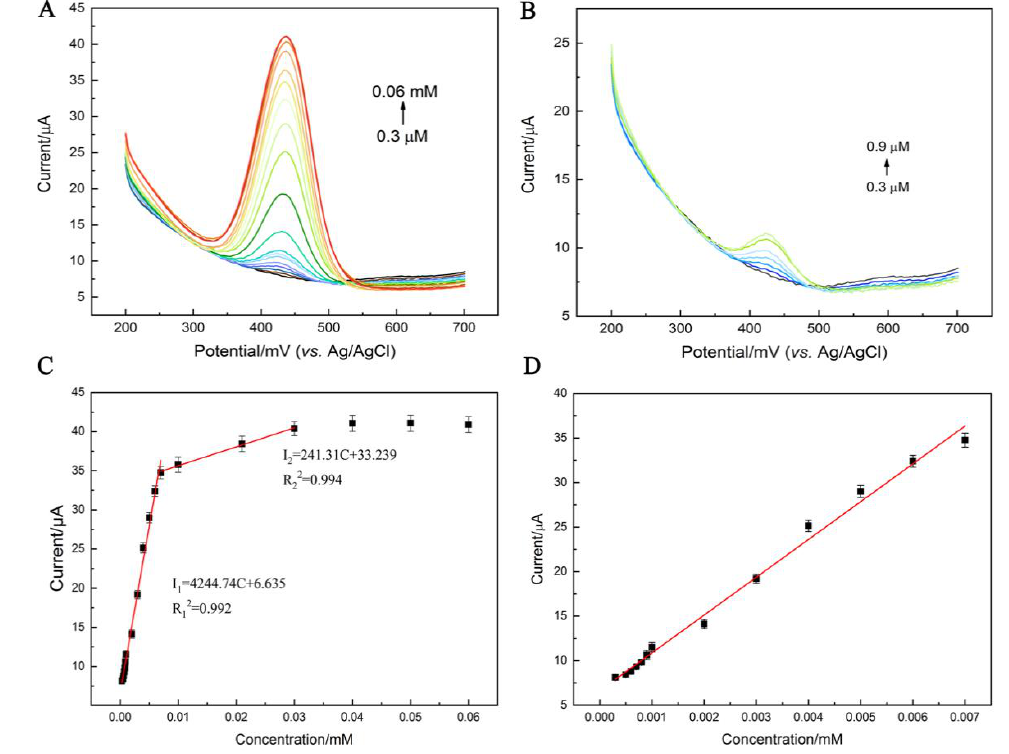
Figure 5. ( A ) Differential pulse voltammetry (DPV) of Au@Pt-PEI-RGO/GCE obtained in Na 2 HPO 4 - citric acid buffer solution (pH 3) containing various concentrations of chicoric acid. ( B ) A close-up of the low concentration of the chicoric acid region from 0.3 μ M to 0.9 μ M. ( C , D ) The corresponding calibration curve of response current versus the concentration of chicoric acid.